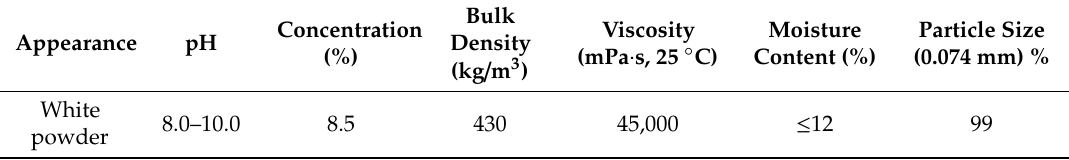
Table 8. Properties of viscosity modifying